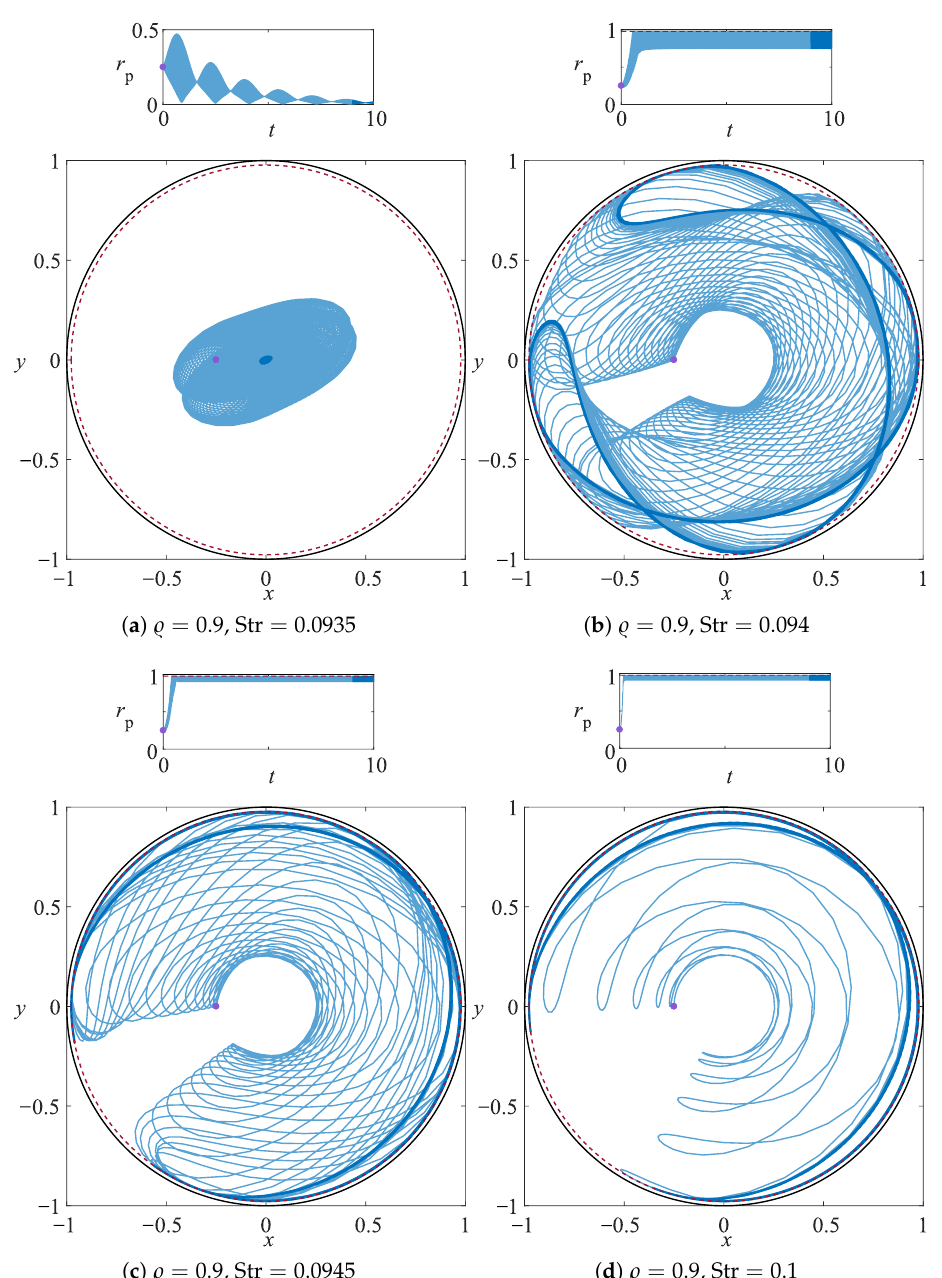
Figure 4. Radial coordinate r p of a particle trajectory for (cid:36) = 0.9, St = 1 and Str = 0.0935, 0.094, 0.0945, and 0.1. The trajectories are integrated for t = 10 and they are denoted by the light-blue line. The darkblue solid line shows the last 10% of the particle orbit and the purple dot its initial position. The red dashed line identifies the sliding surface of the PSI model, which surface is at distance ∆ = a from the driving